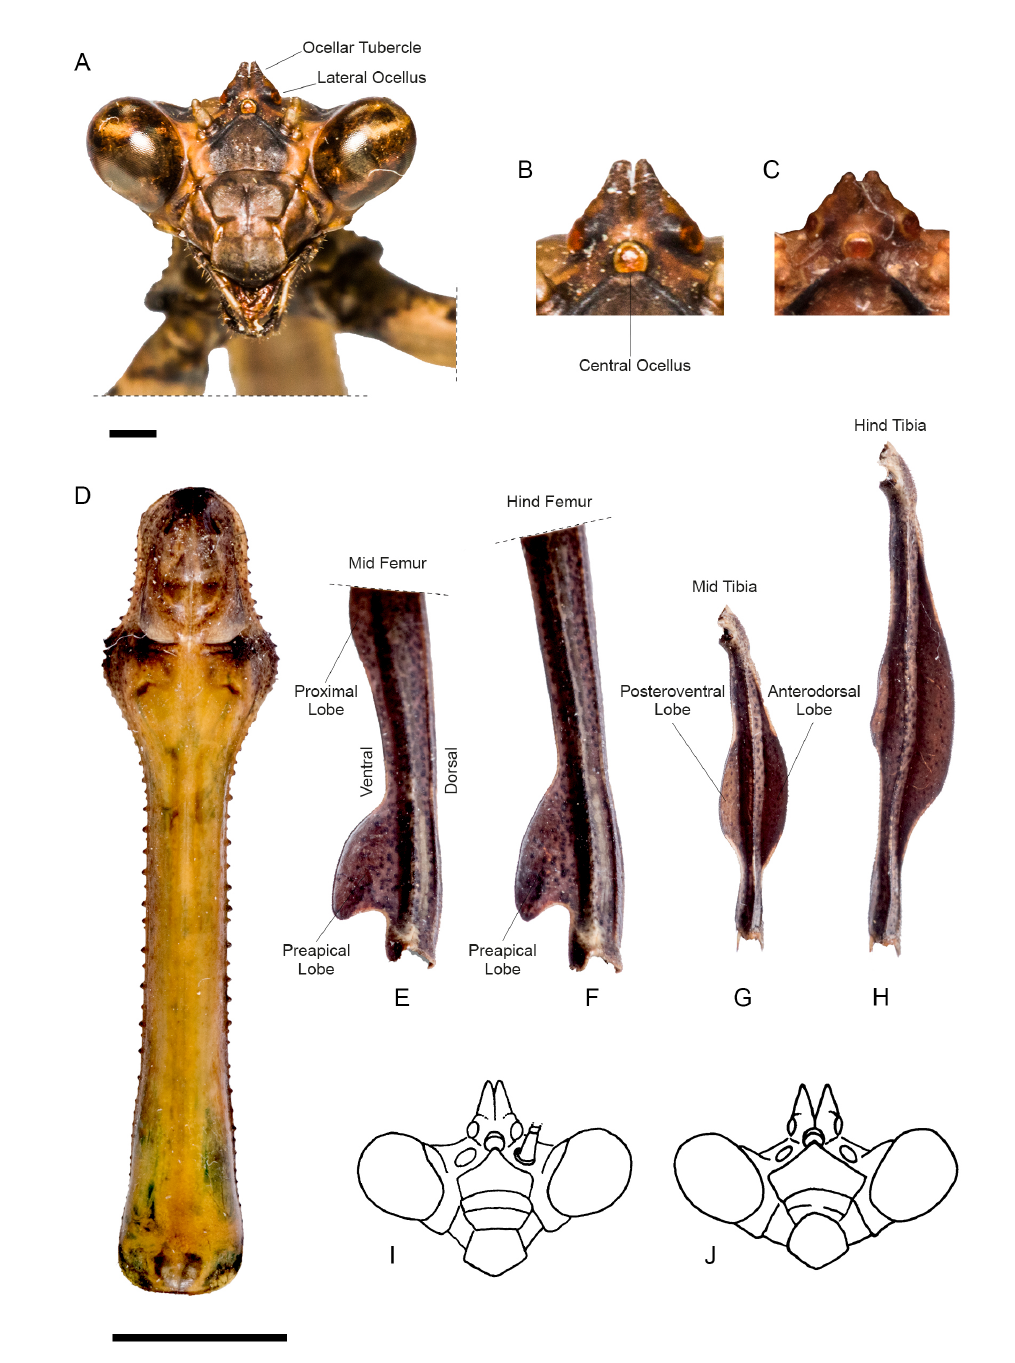
Fig. 6. Vates phoenix sp. nov., female morphology (both specimens are from Jardim Botânico do Rio de Janeiro), and head morphology of Vates spp. A . Head, frontal view, allotype (MNRJ-ENT6-28442). – B – C . Variation in ocellar tubercles (not to scale). B . Allotype (collected in 2018; MNRJ-ENT6-28442). C . Paratype (collected in 1935; MNRJ-ENT6-28455). – D . Pronotum, dorsal view, allotype (MNRJ- ENT6-28442). – E – H . Mid- and hind legs, allotype (MNRJ-ENT6-28442). E . Mid-femur, detail of distal section. F . Hind femur, detail of distal section. G . Mid-tibia. H . Hind tibia. – I . Vates biplagiata Sjöstedt, 1930, head, frontal view (male specimen from Peru). J . Vates weyrauchi Beier, 1958, head, frontal view (male specimen from Peru). Scale bars: A = 1 mm; D–H = 5